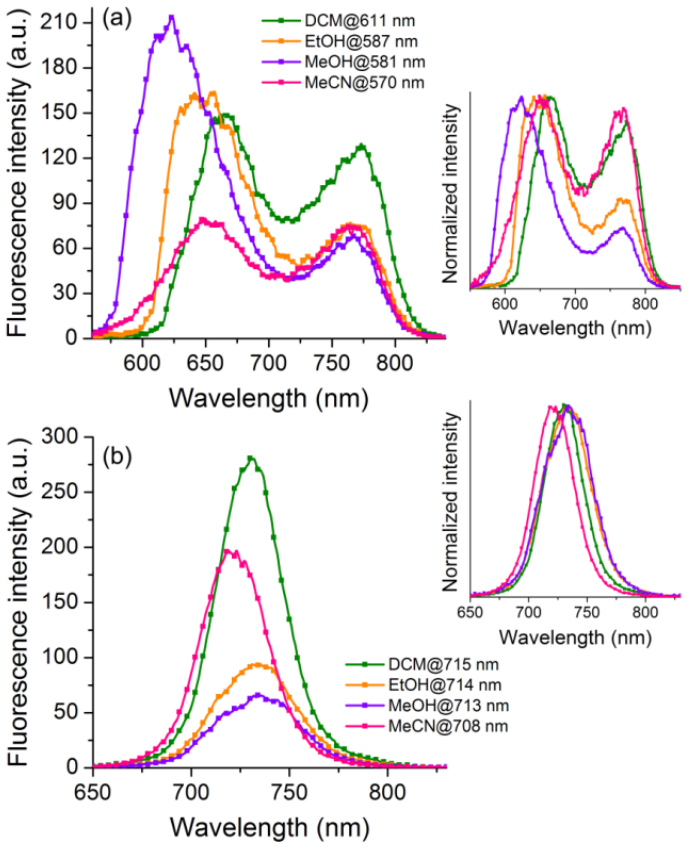
Figure 3. Steady-state fluorescence emission spectra of heptamethine cyanine dye 8b in a solution of different organic solvents (~10 − 6 M) at excitation wavelength between ( a ) 581 and 611 nm (Table 2) and ( b ) 708 and 715 nm (Table S2). The inset shows the respective normalized spectra. (DCM = dichloromethane, MeCN = acetonitrile and MeOH =